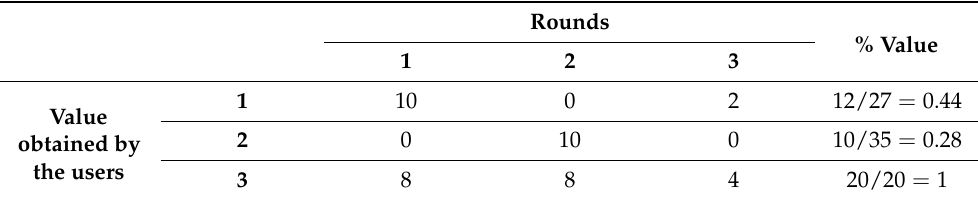
Table 2. Users’ values obtained with standard majority